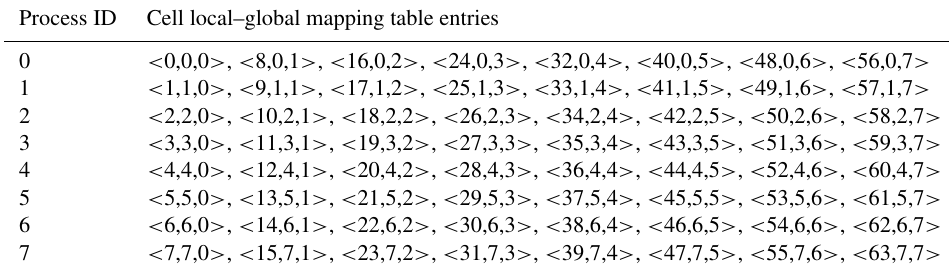
Table 2. The cell local–global mapping table (CLGMT) of the parallel decomposition in Fig. 1b. Process ID Cell local–global mapping table